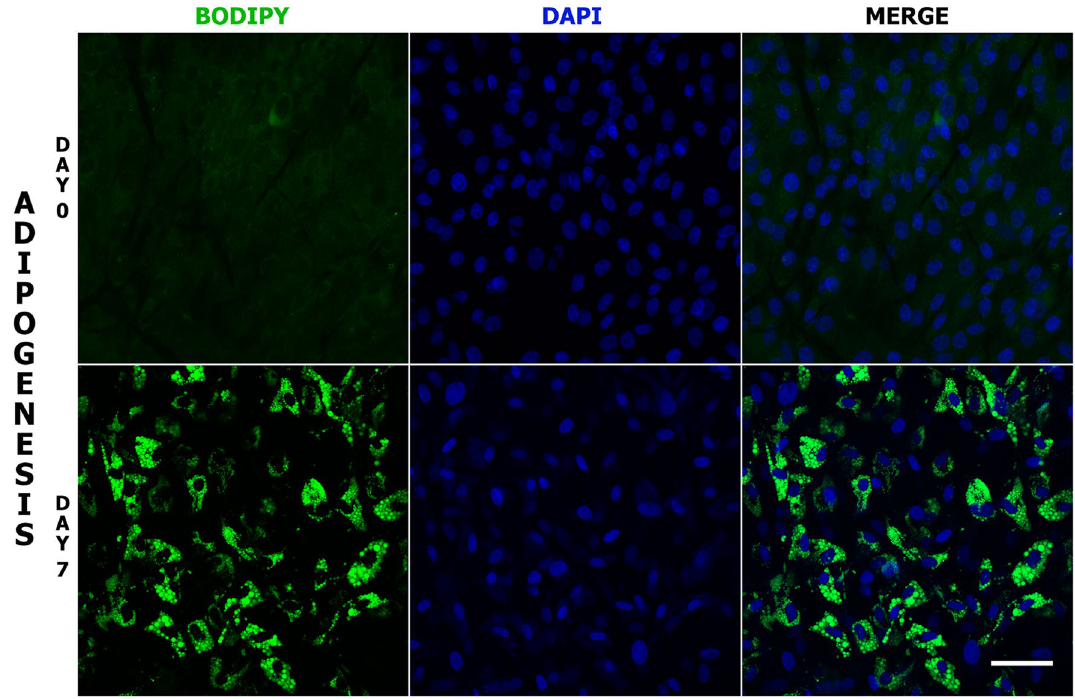
Figure 1. Monitoring of lipid droplet formation during in vitro adipogenesis. Visualization of lipid droplets in AD-MSC on days 0 and 7 of adipogenic differentiation. The droplets were stained with BODIPY (green) while the nuclei were counterstained with DAPI (blue). Scale bar: 50